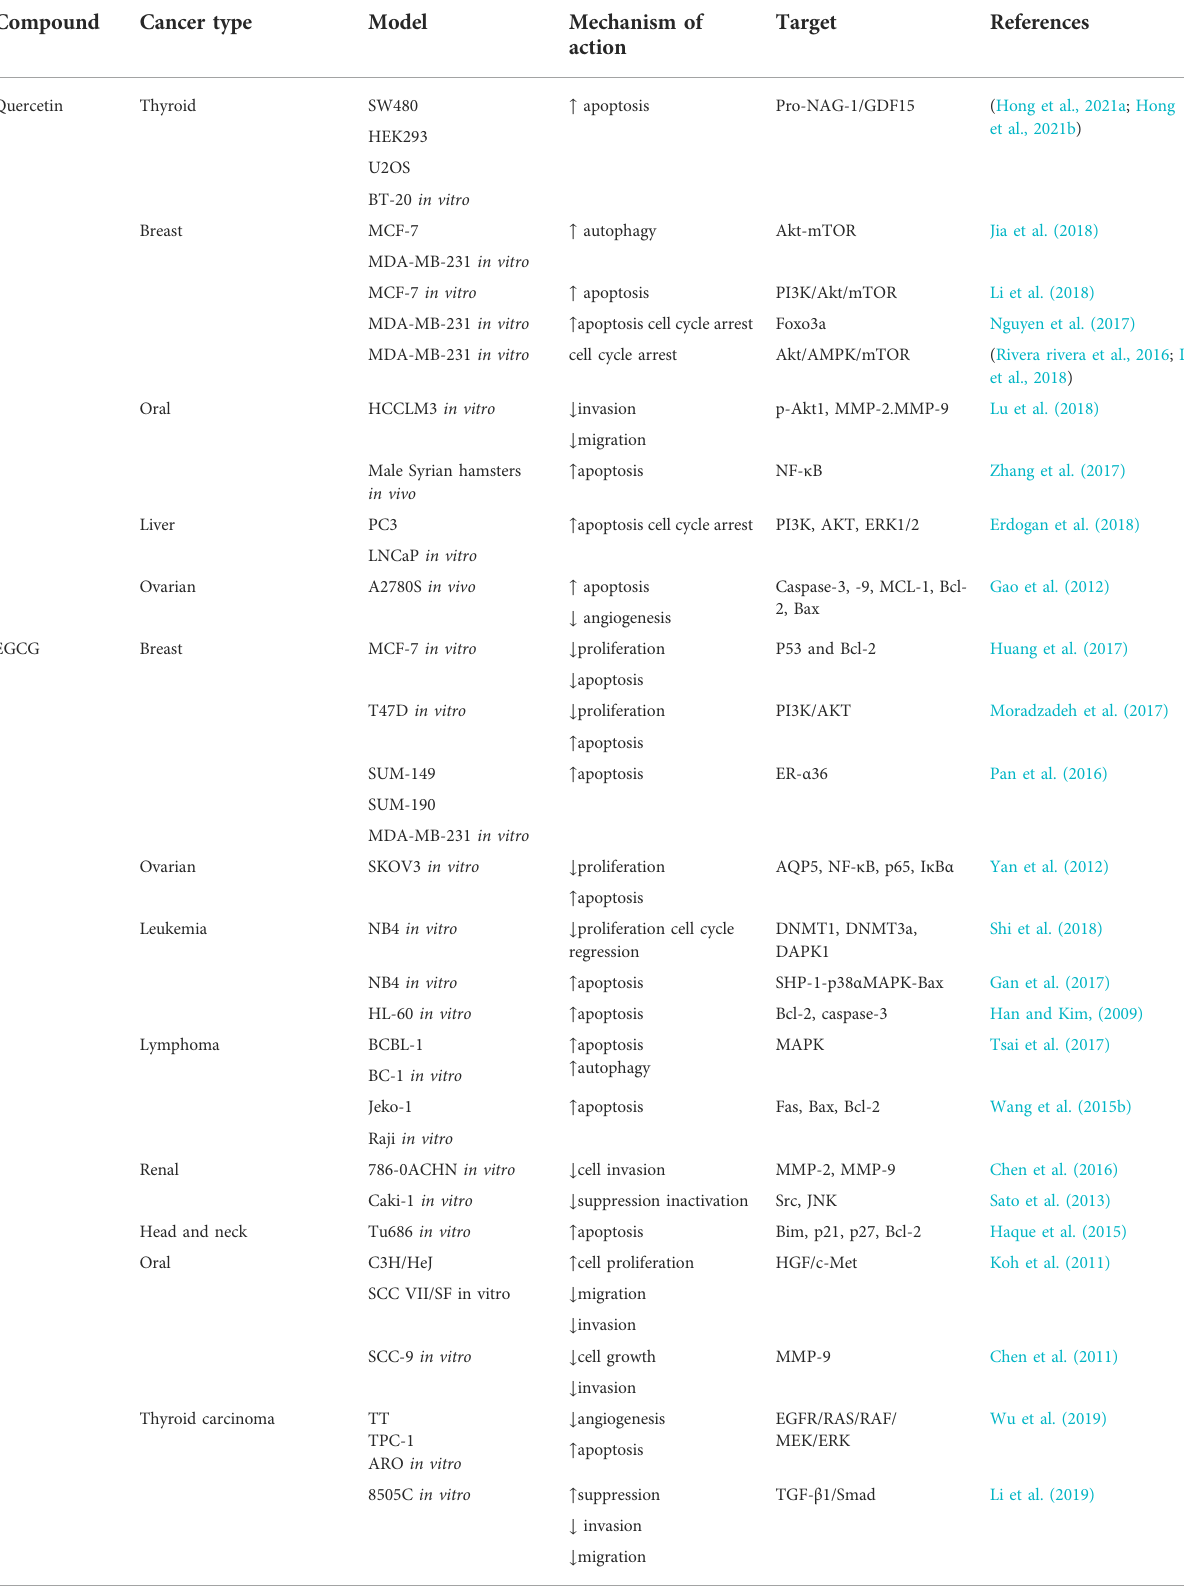
TABLE 1 Anticancer perspectives of polyphenols along with their mechanism of action and signaling